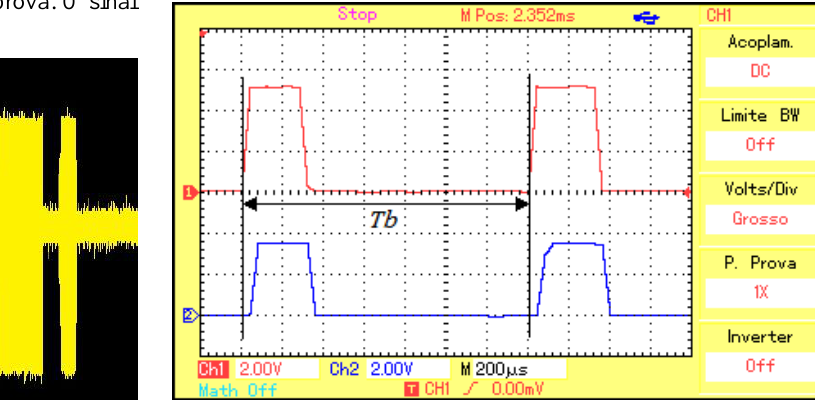
Figura 8: Imagem do primeiro valor baixo da sequência. Fonte: Autores,